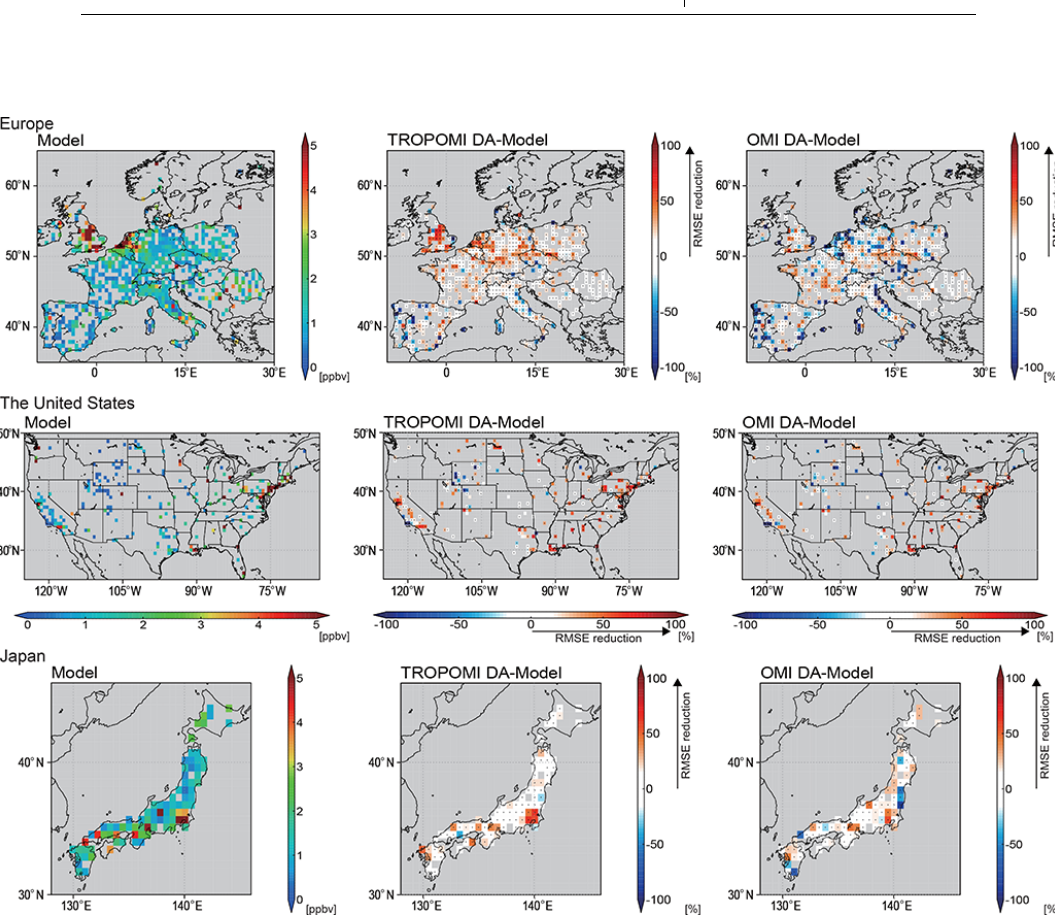
Figure 6. Root-mean-square errors (RMSEs) against surface in situ observations for surface NO 2 concentration fields (ppbv) at 14:00LT (local time) in the control model simulation (left column) and their reductions (%) by Tropospheric Monitoring Instrument (TROPOMI) data assimilation (DA) and Ozone Monitoring Instrument (OMI) DA (middle and right columns, respectively) over Europe (top), the United States (middle), and Japan (bottom). The values are mapped onto 0.56 ◦ resolution grids. For the middle and right columns, grids with open circles indicate RMSE reductions that are statistically significant at the 95% confidence level using the Mann–Whitney U test.